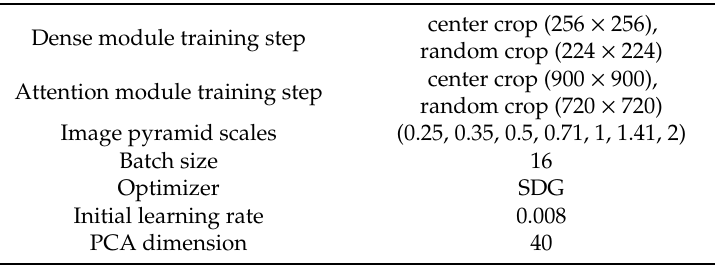
Table 3. The network configuration for feature extraction.